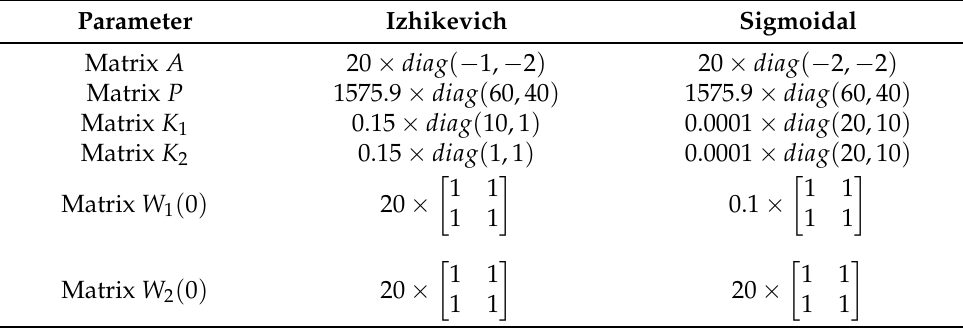
Figure 6. Identification with sigmoidal activation function for low-frequency rotations: ( a )—recorded head rotation; ( b )—identification error; ( c )—recorded data and identification results comparison; ( d )—evolution of weights. Table 1. Parameters of the compared